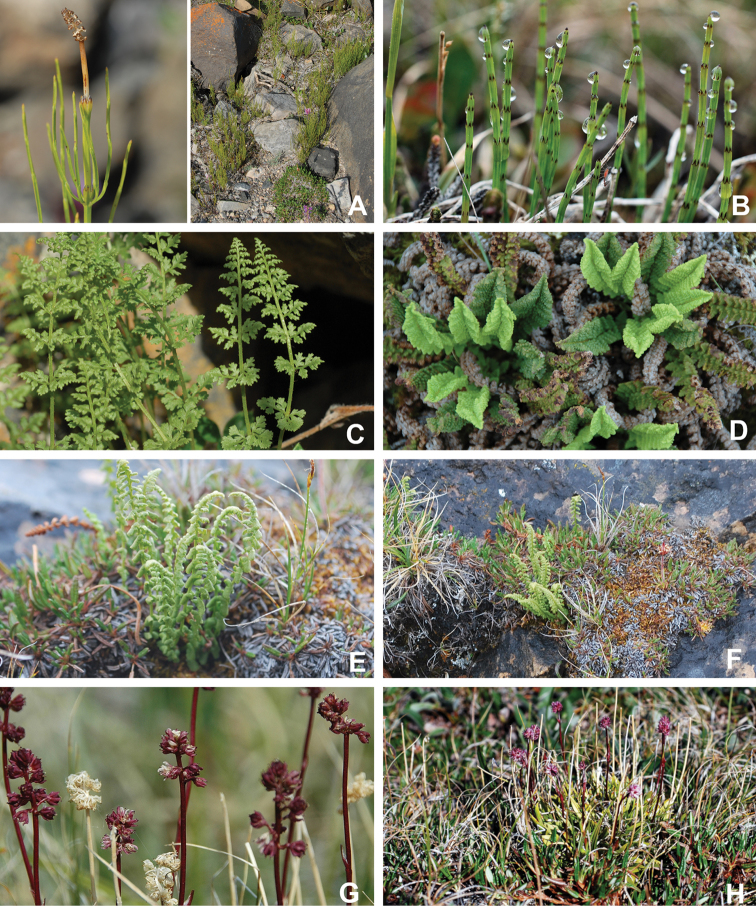
AEquisetum
arvense
subsp.
alpestre strobilus (left) and habit (right), Gillespie et al. 10109BEquisetum
variegatum
subsp.
variegatum habit, Gillespie et al. 8499CCystopteris
fragilis habit, Gillespie et al. 9990DDryopteris
fragrans habit, Johansen Bay, 18 July 2008 EWoodsia
glabella habit FWoodsia
glabella habitat GTofieldia
coccinea inflorescences, Kuujjua River, NT, 18 July 2010 HTofieldia
coccinea habit, Gillespie et al. 9749. Photos A, C by L.J. Gillespie B, D, G by R.D. Bull H by J.M. Saarela and E, F by B.A. Bennett.